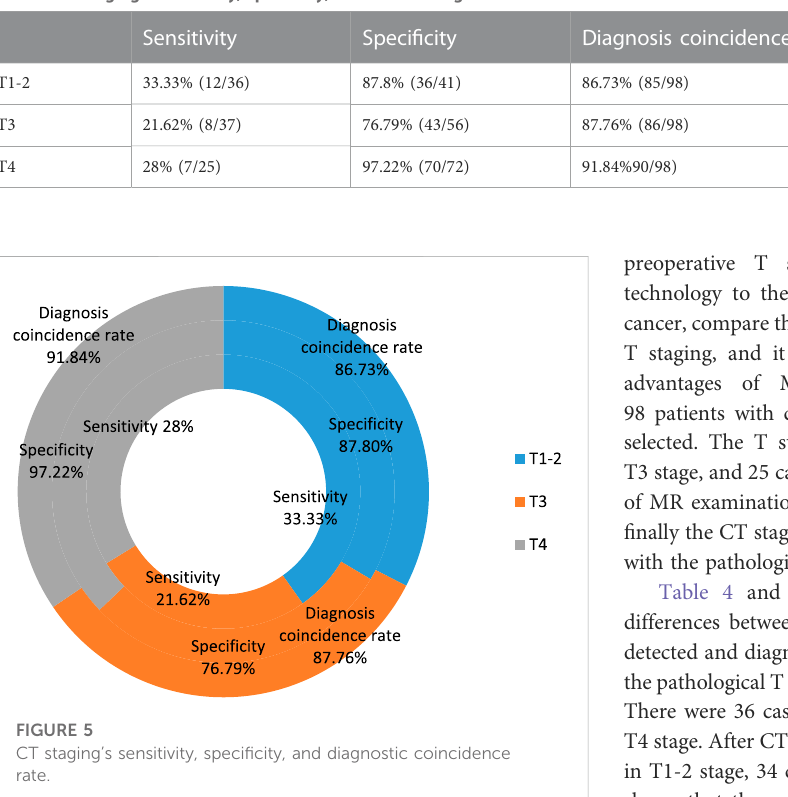
(2) Evaluation of the sensitivity, speci fi city, and diagnostic coincidence rate of MR staging